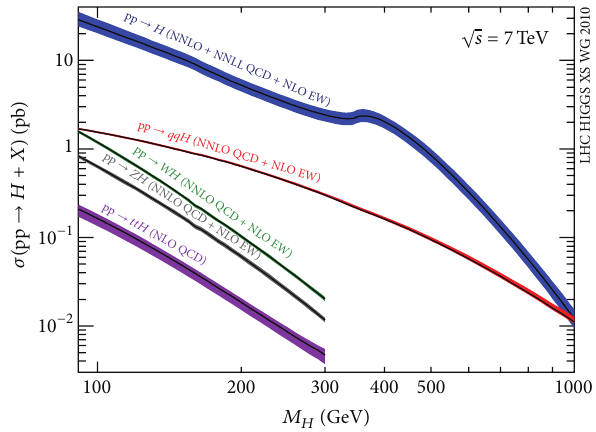
Figure 21: Higgs production cross sections at the LHC for √𝑠 = 8 TeV together with the uncertainties from the missing higher order corrections and the parton density functions from